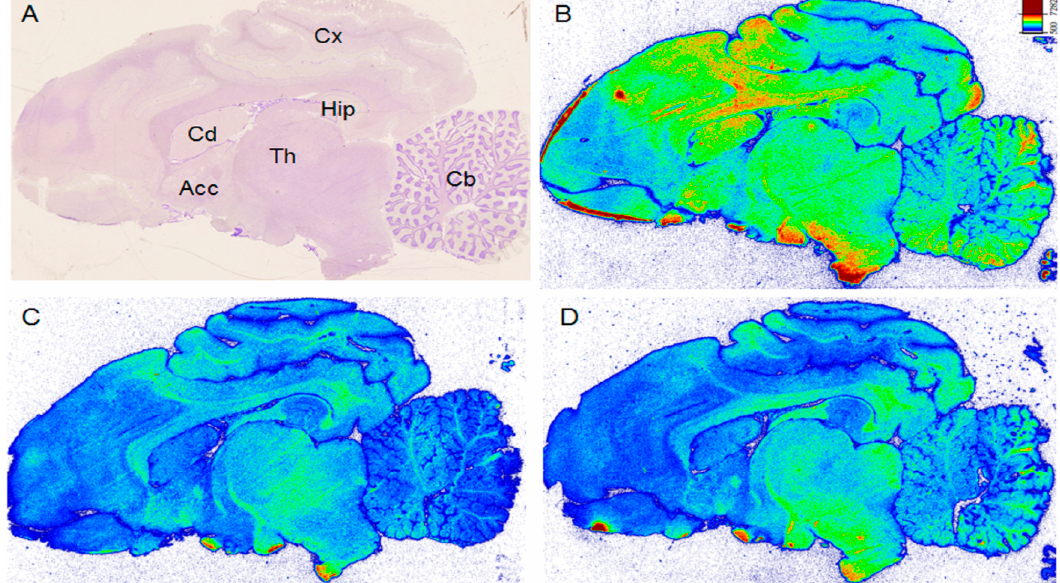
Figure 4. In vitro autoradiography of [ 18 F] BIT1 in pig brain slices, ( A ) Nissl staining, ( B ) Total binding of 1.72 nM of [ 18 F] BIT1 , ( C ) Blocking studies (10 μ M of TA1 ), ( D ) Self-blocking (10 μ M of of 1.72 nM of [ 18 F] BIT1 , ( C ) Blocking studies (10 µ M of TA1 ), ( D ) Self-blocking (10 µ M of BIT1